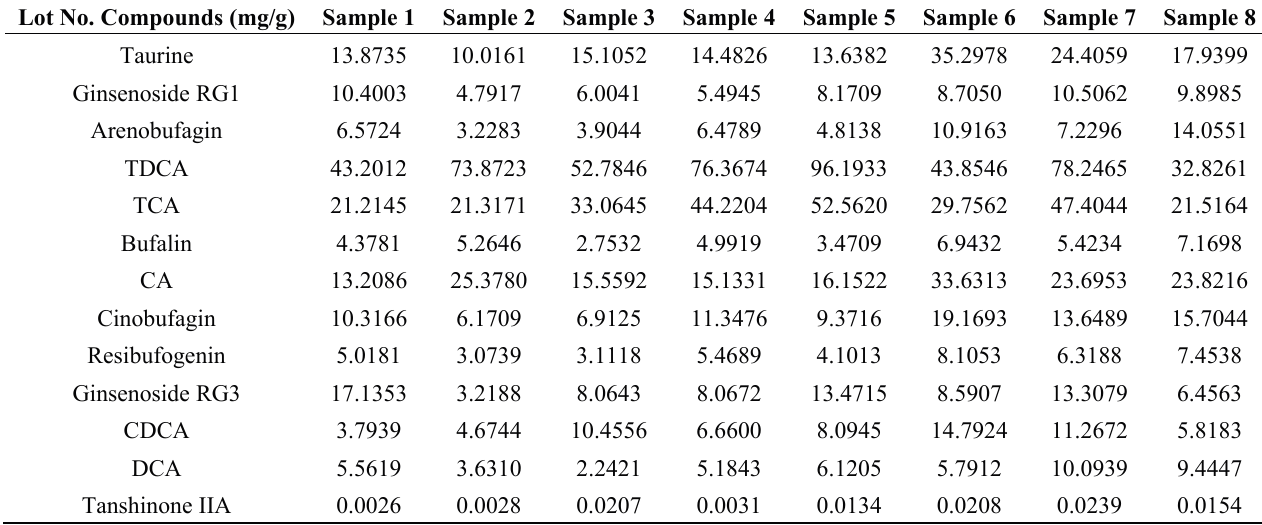
Table 5. Contents of 13 analytes in different STP